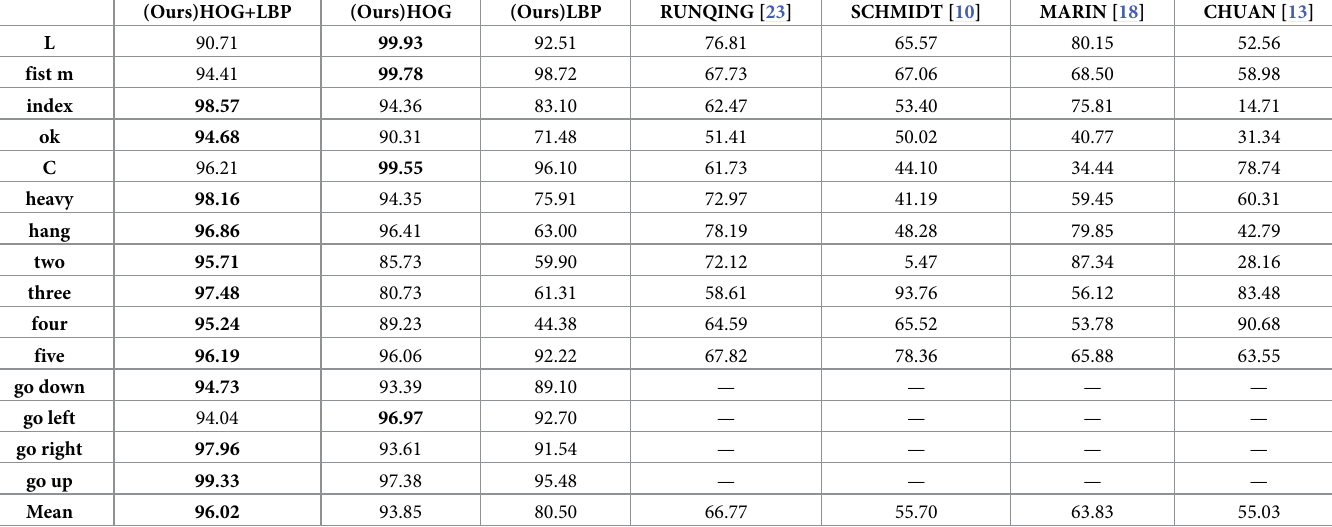
Table 2. Hand gesture recognition performance comparison with state-of-the-art works. In bold, the highest score per row.